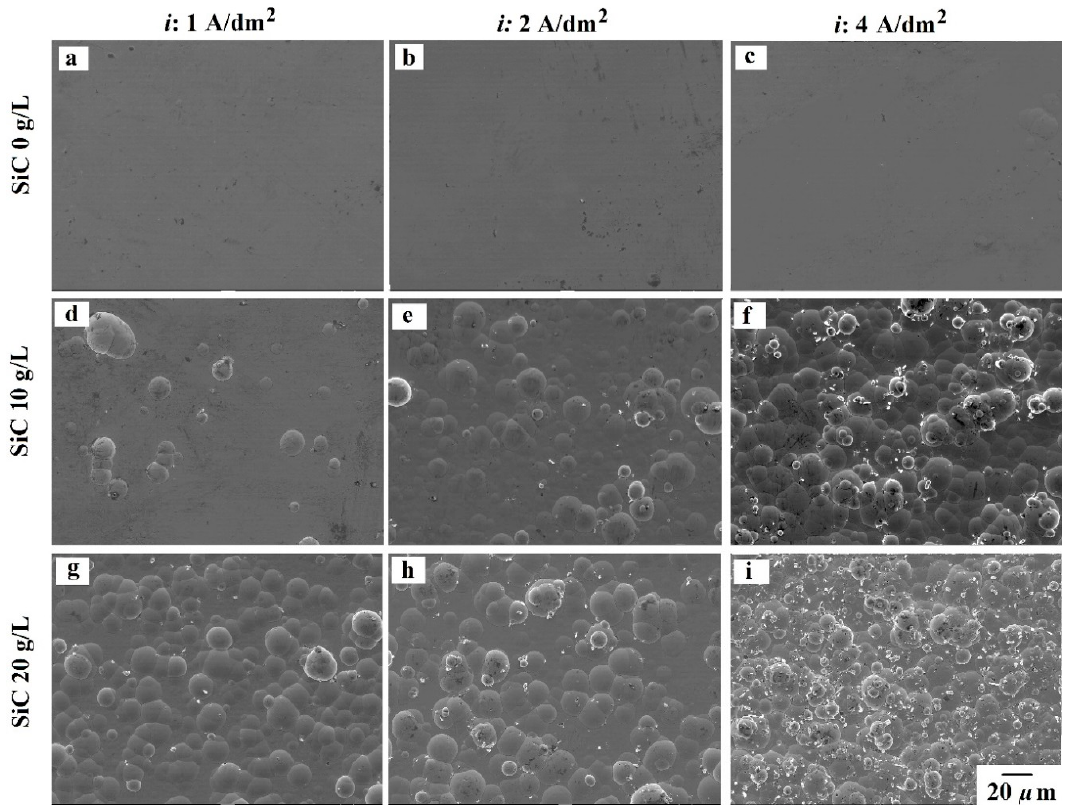
Figure 2. SEM images of surface of ( a – c ) NiP, ( d – f ) NiP/10SiC, ( g – i ) NiP/20SiC. ( a , d , g ) i : 1 A/dm 2 , ( b , e , h ) i : 2 A / dm 2 , ( c , f , i ) i : 4 A / dm 2 deposited from bath 1.